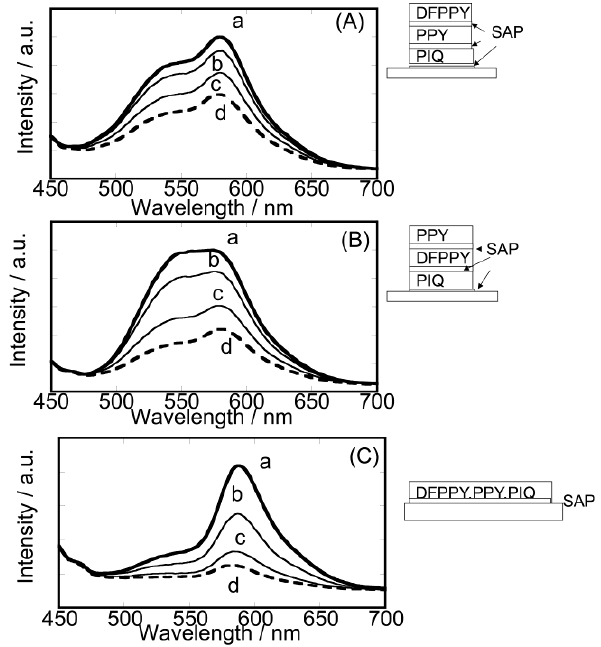
Figure 6. The luminescence spectra of the triple-layered hybrid LB films of ( A ) {DFPPY/SAP/PPY/SAP/PIQ/SAP}, ( B ) {PPY/SAP/DFPPY/SAP/PIQ/SAP}, ( C ) {DFPPY,PPY,PIQ/SAP}. The excitation wavelength was 430 nm. The vertical axis denotes the intensity of luminescence at an arbitrary unit. a: in vacuum, b: 4 kPa, c: 27 kPa, d: 101.3 kPa of oxygen pressure (modified from reference